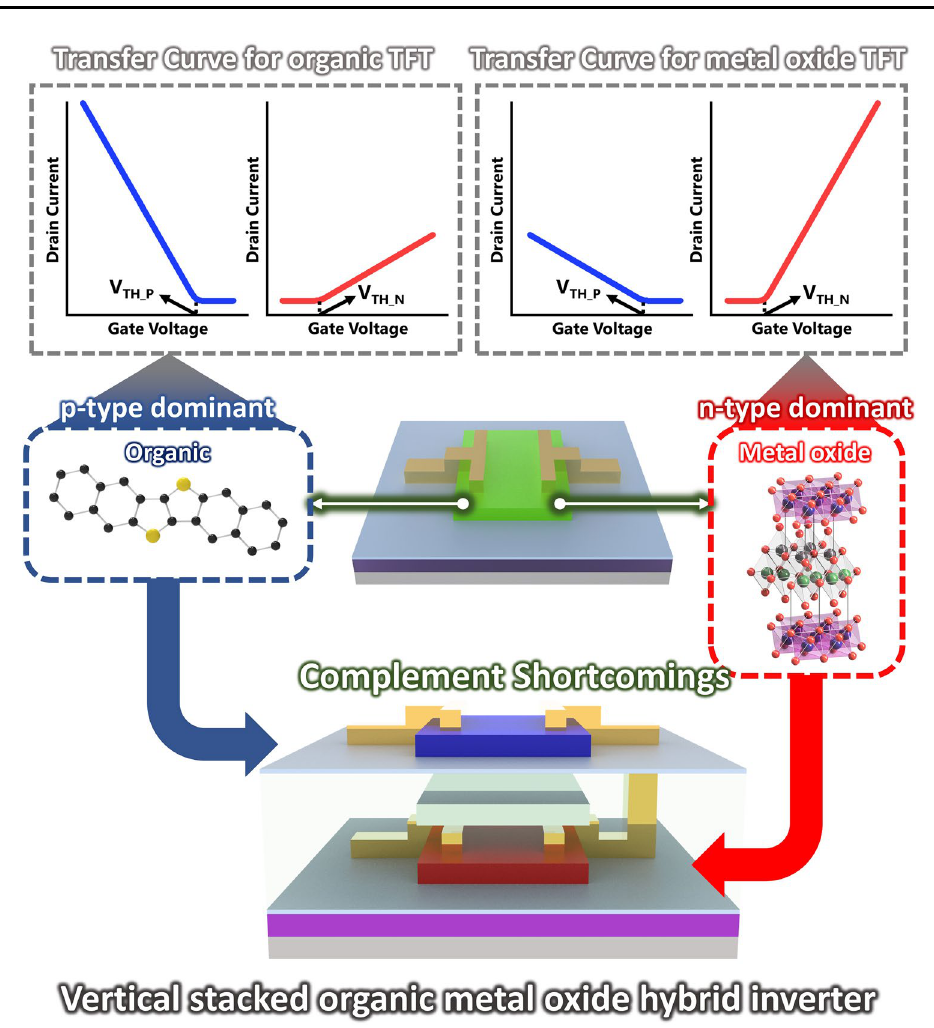
Fig. 5 Schematic diagram of a vertical stacked p-type organic semiconductor and n-type metal oxide hybrid inverter capable of complementary